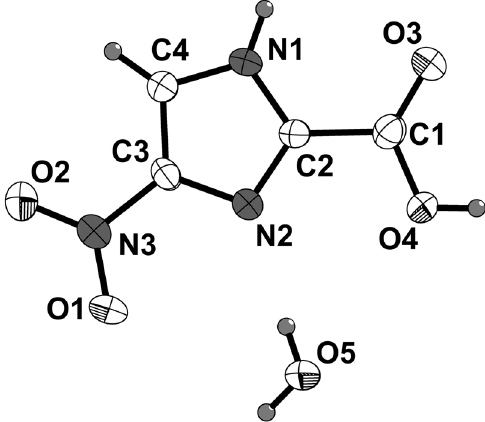
Table  : Data collection and